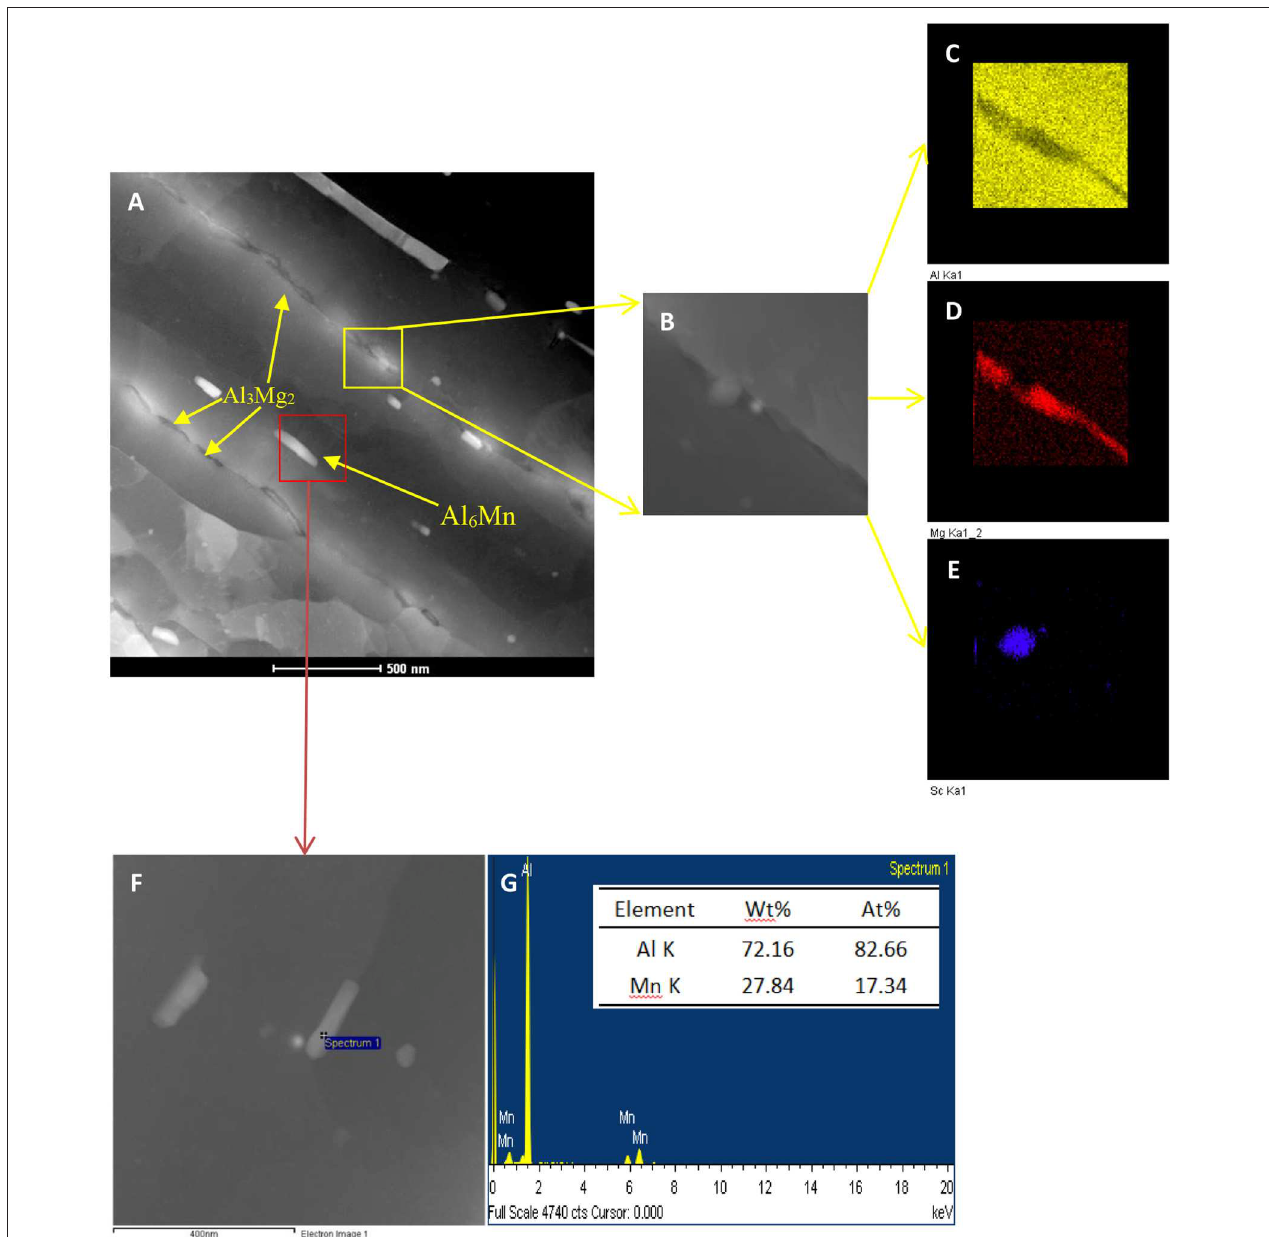
FIGURE 6 | HAADF image from TEM and EDS analysis of the Sc-containing cold rolling plates annealed at 200 ◦ C for 2h. (A) HAADF image; (B) zoom in image; (C) detection of Al by map scanning; (D) detection of Mg by map scanning; (E) detection of Sc by map scanning; (F) zoom in image; (G) EDS analysis.